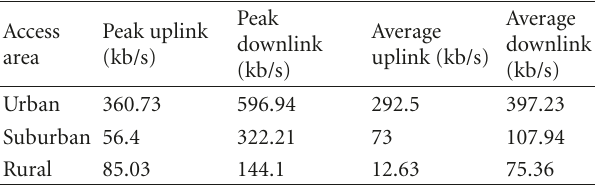
Table 8: Tra ffi c per subscriber.